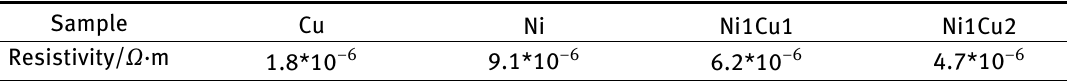
Table 1: Conductivity of Cu, Ni, Ni1Cu1, and Ni1Cu2 powders.